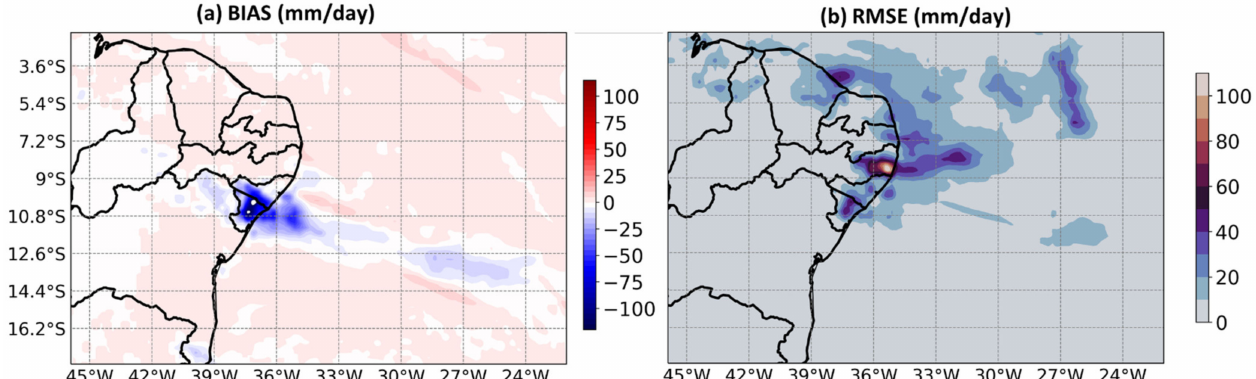
Figure 16. ( a ) Distribution of the bias resulting from the statistical analysis between the rainfall simulated by the RegCM model and the TRMM satellite’s observation. ( b ) The distribution of the RMSE resulted from the statistical analysis between the rain simulated by the RegCM model and the TRMM satellite’s